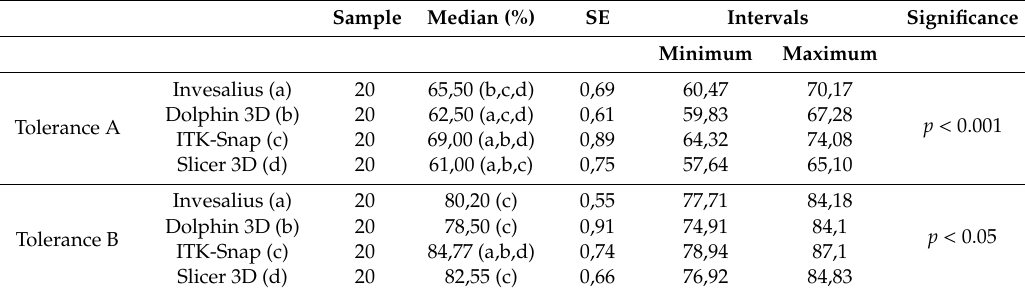
Table 3. Comparison among the matching percentage between the mandibular models obtained with di ff erent semi-automatic segmentation software and the ground truth mandibular model (manual segmentation), according to the deviation analysis. Significance set at p < 0.05, according to the